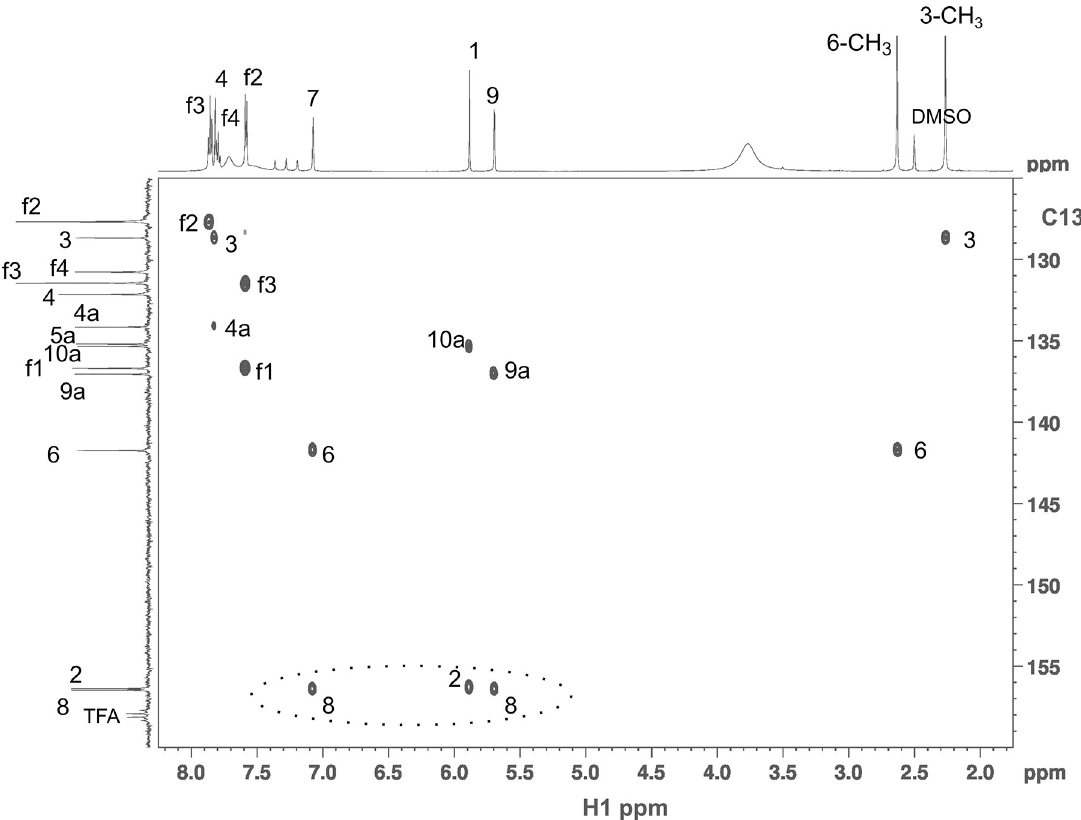
Fig 5. The 1,1 ADEQUATE spectrum of safranine III. The boxed area at the lower left is unambiguous evidence that the methyl group in III is at position